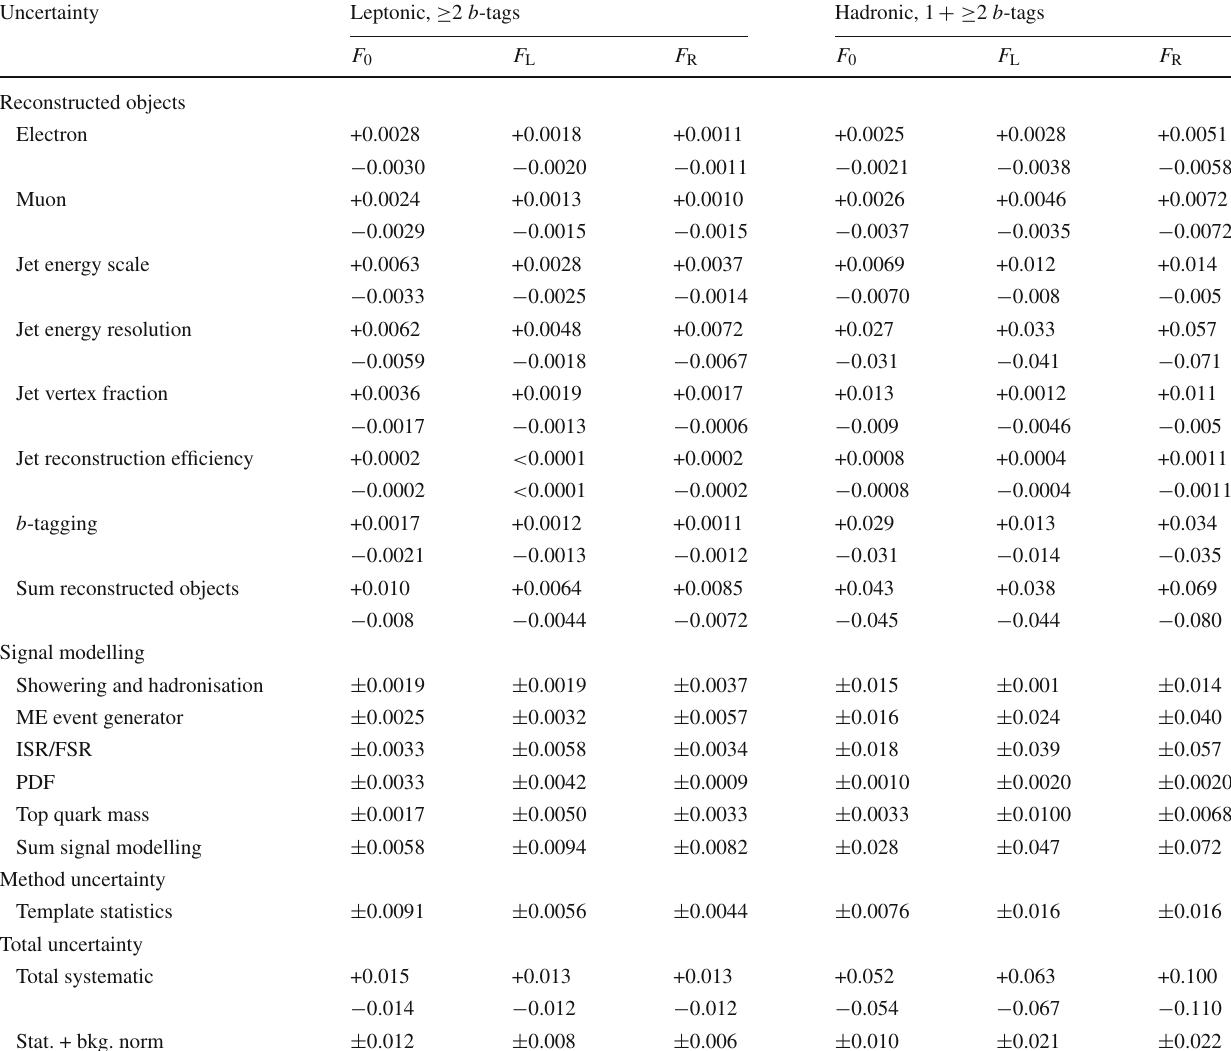
Table 4 Summary of systematic and statistical uncertainties for the measurements obtained using the leptonic (left) and the hadronic (right) analysers.Thenumbers inthelastrow(Stat.+bkg. norm)correspond to Uncertainty Leptonic, ≥ 2 b